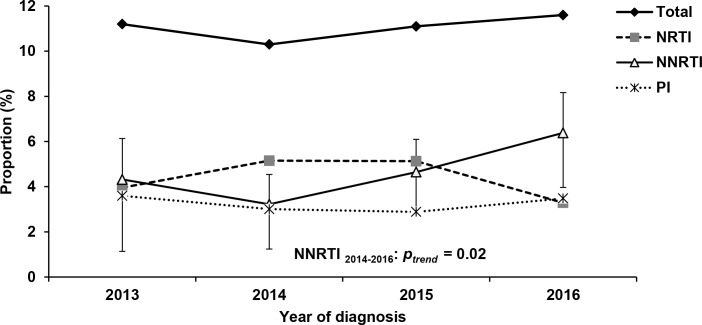
Trends of transmitted drug resistance among newly diagnosed HIV cases with recent HIV infections in total and according to drug classes.The confidence interval for NNRTI resistance is indicated.